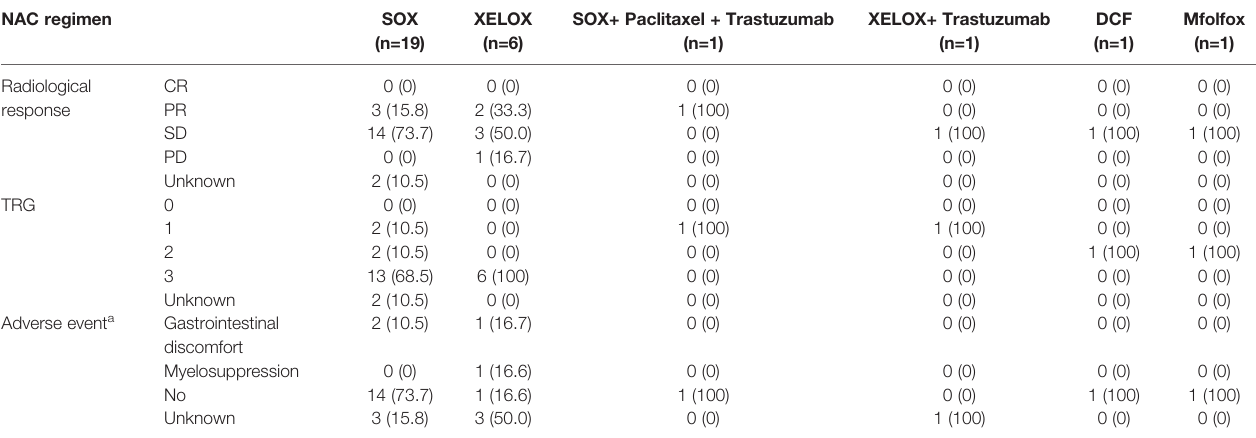
TABLE 2 | Evaluation of radiological response, TRG, and main toxicity occurring of NAC. NAC regimen